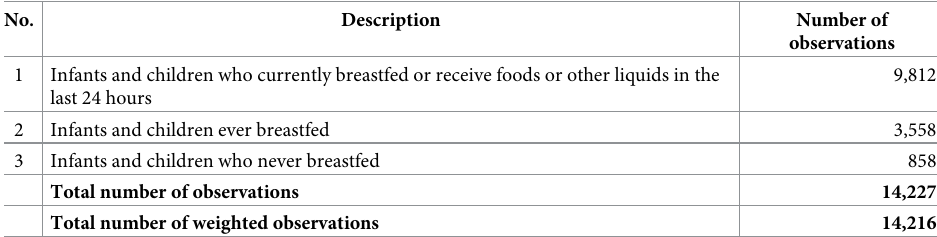
observations 9,812